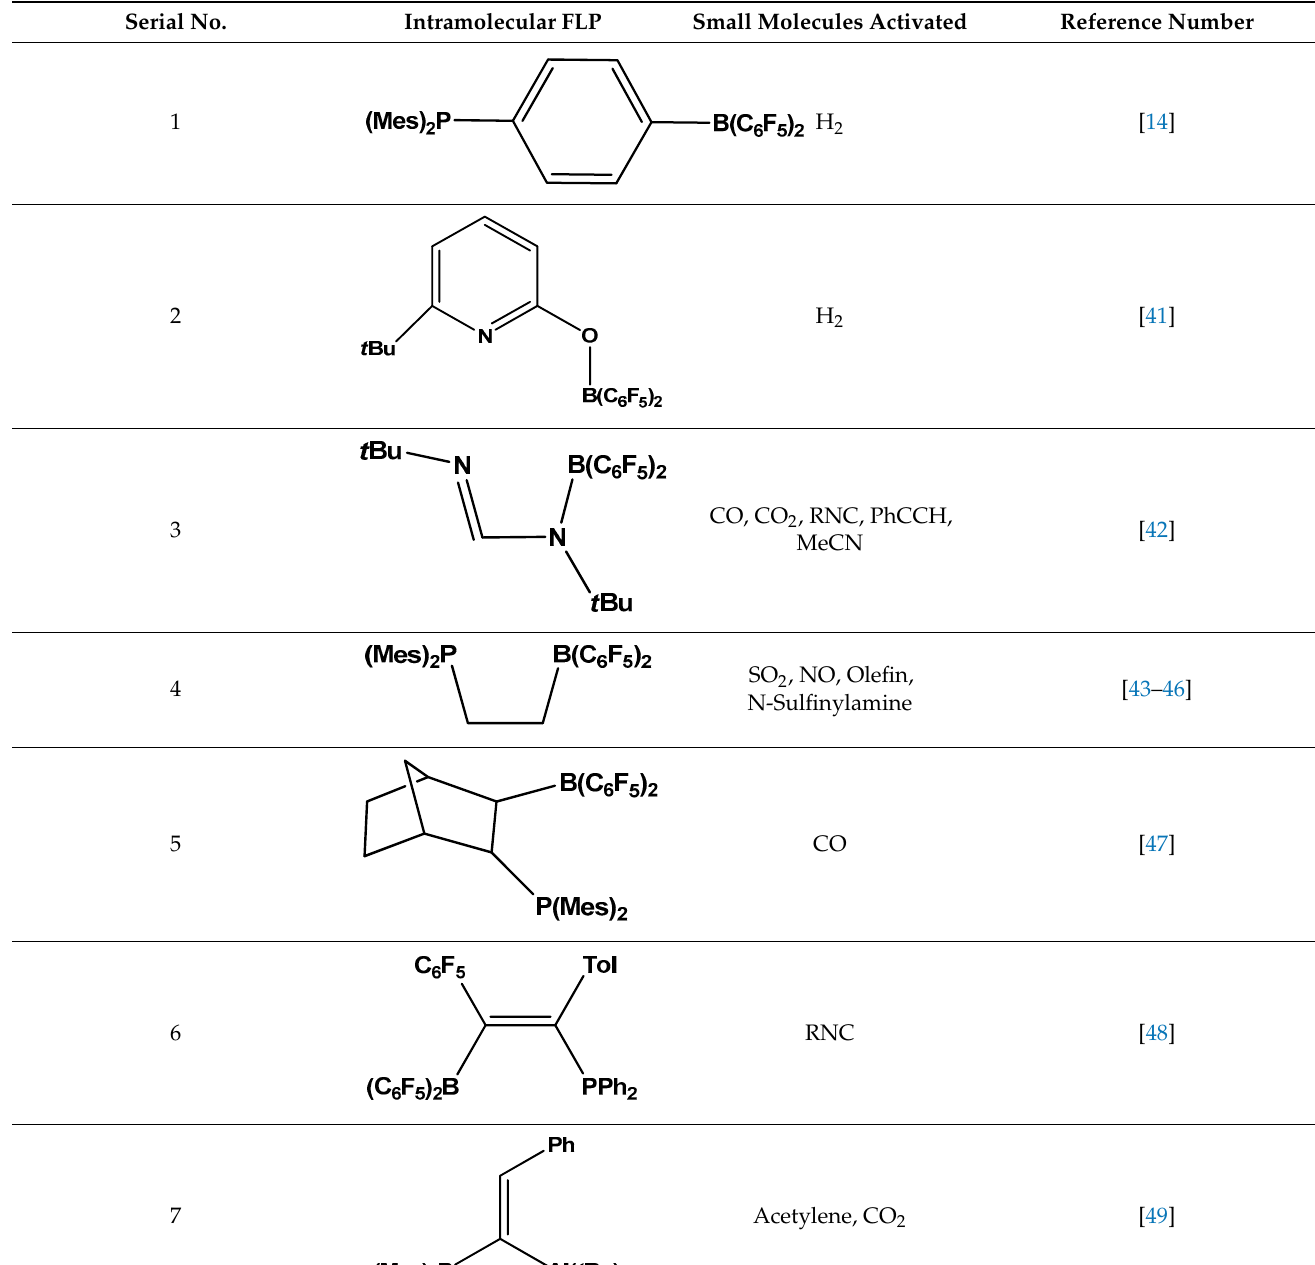
Table 2. Structures of some intramolecular FLPs and their role. Serial No.